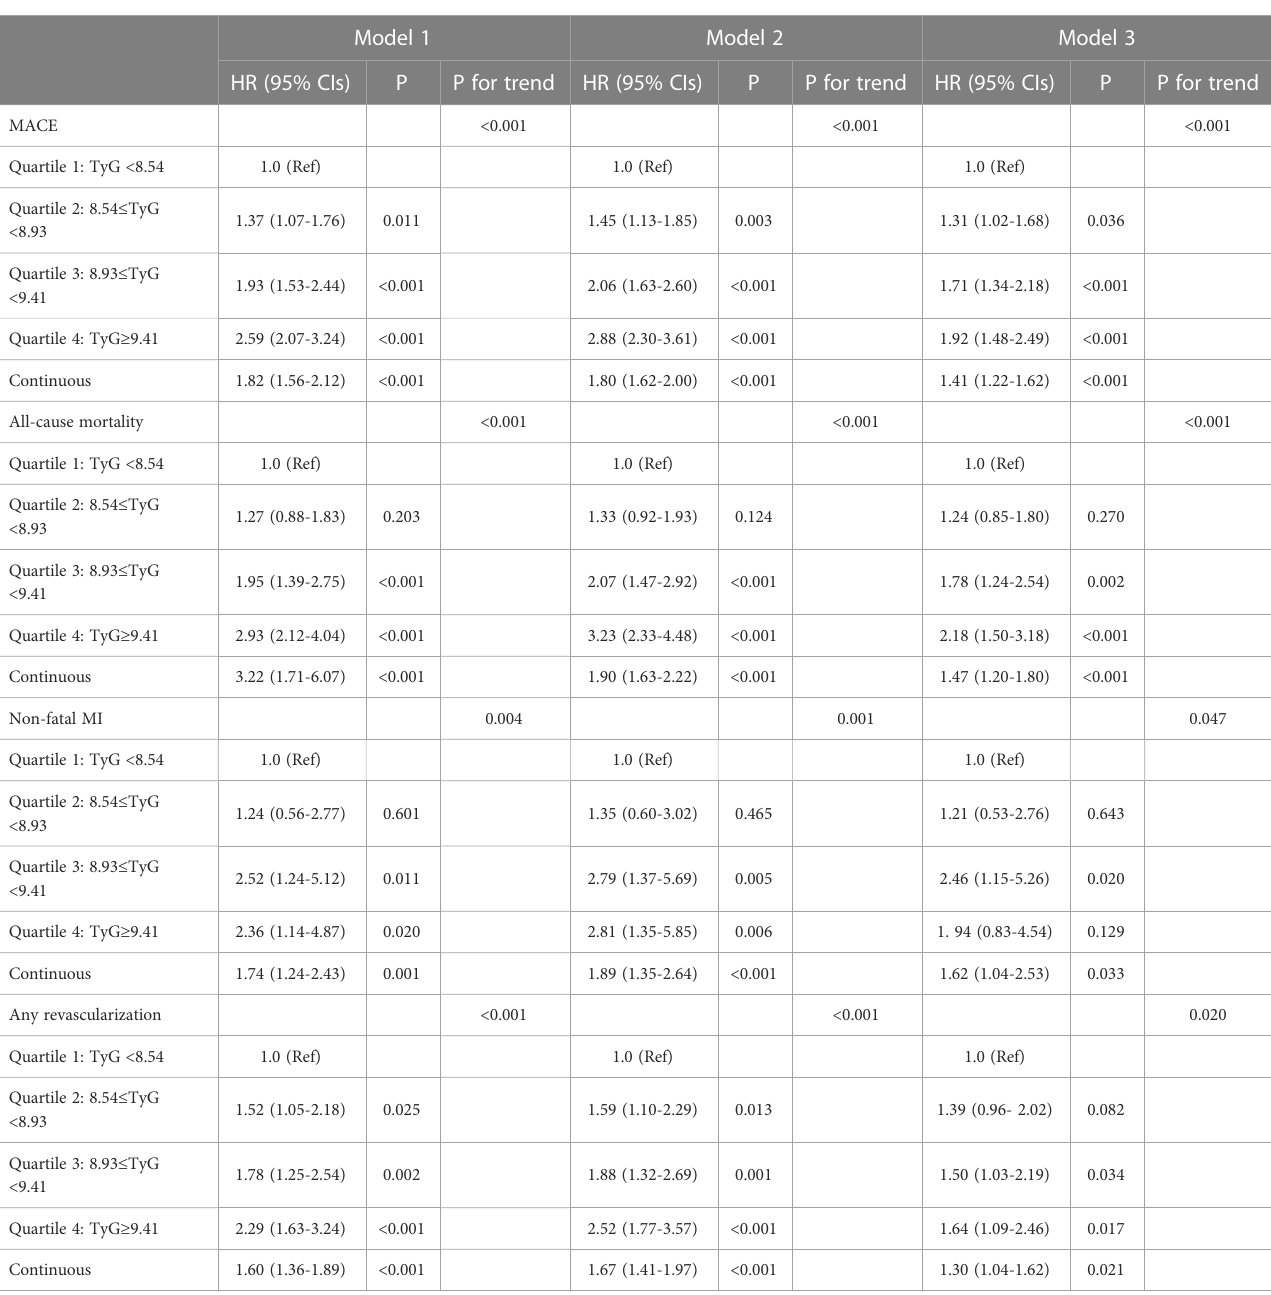
TABLE 3 The association between TyG and